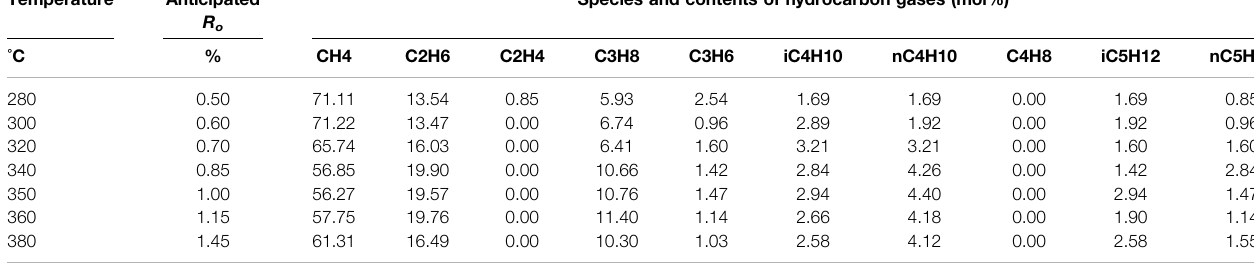
TABLE 4 | Analysis results of hydrocarbon gas generation from stromatolite Temperature